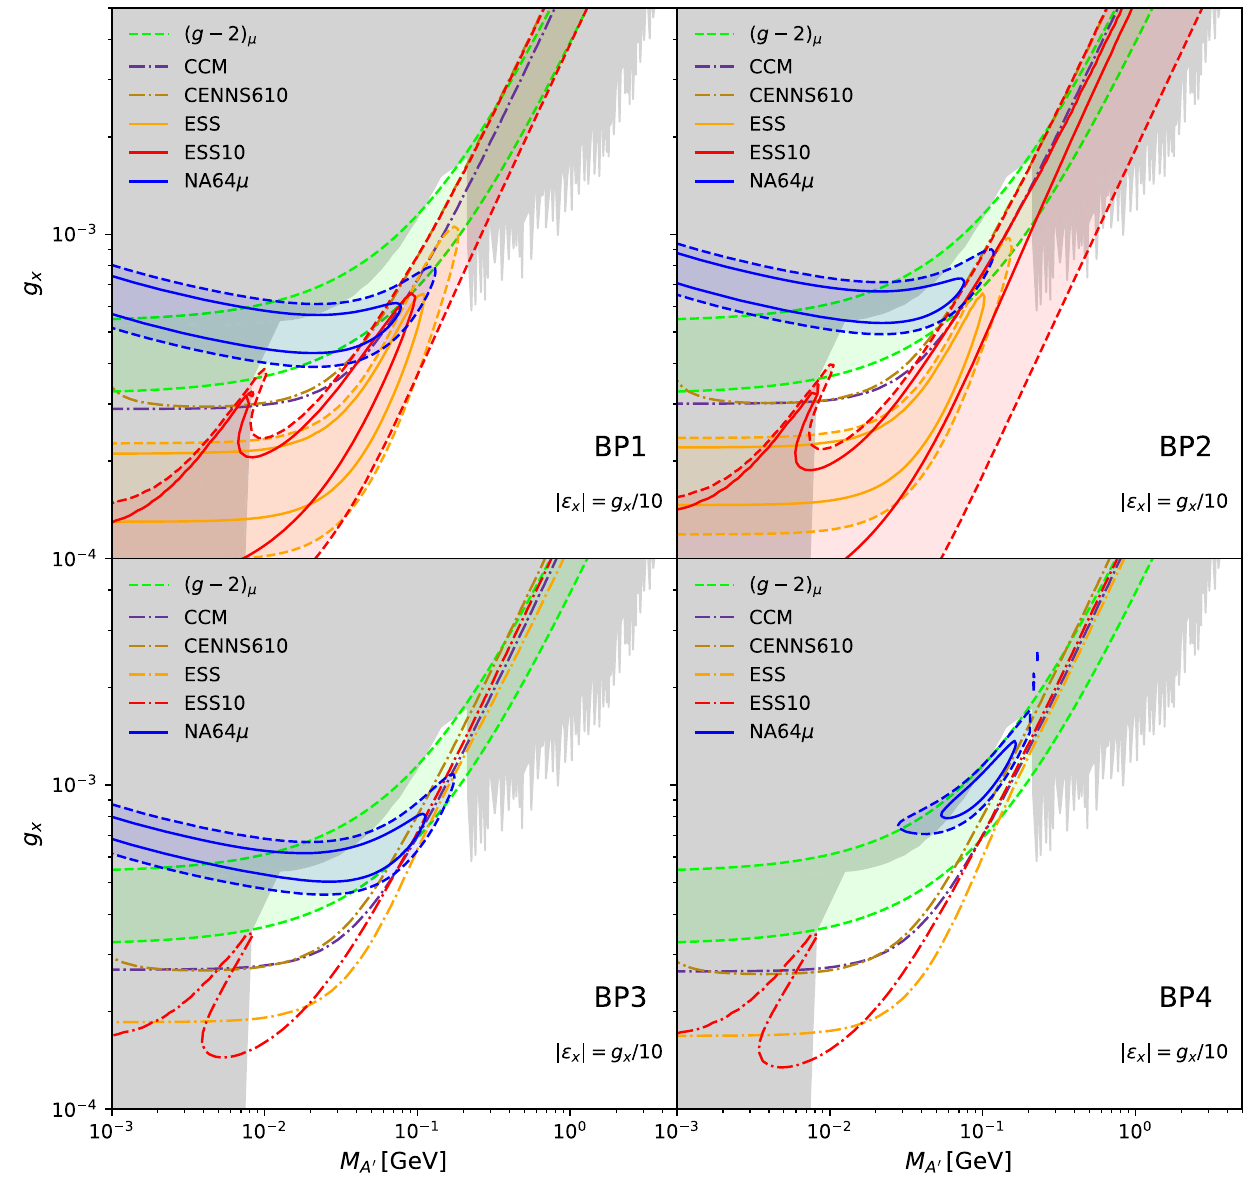
Fig. 9 The same as in Fig. 8, but for (cid:8) x = − g x /